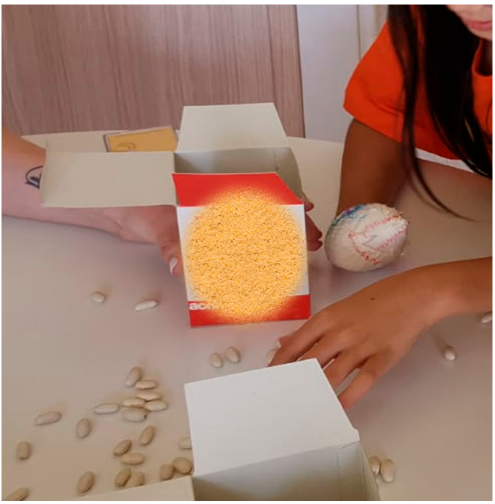
Figure 1. Child with left hemiplegia wearing a bandage as a partial containment in the right hand (dominant hand). In this task, the child is working the grasp–release action.